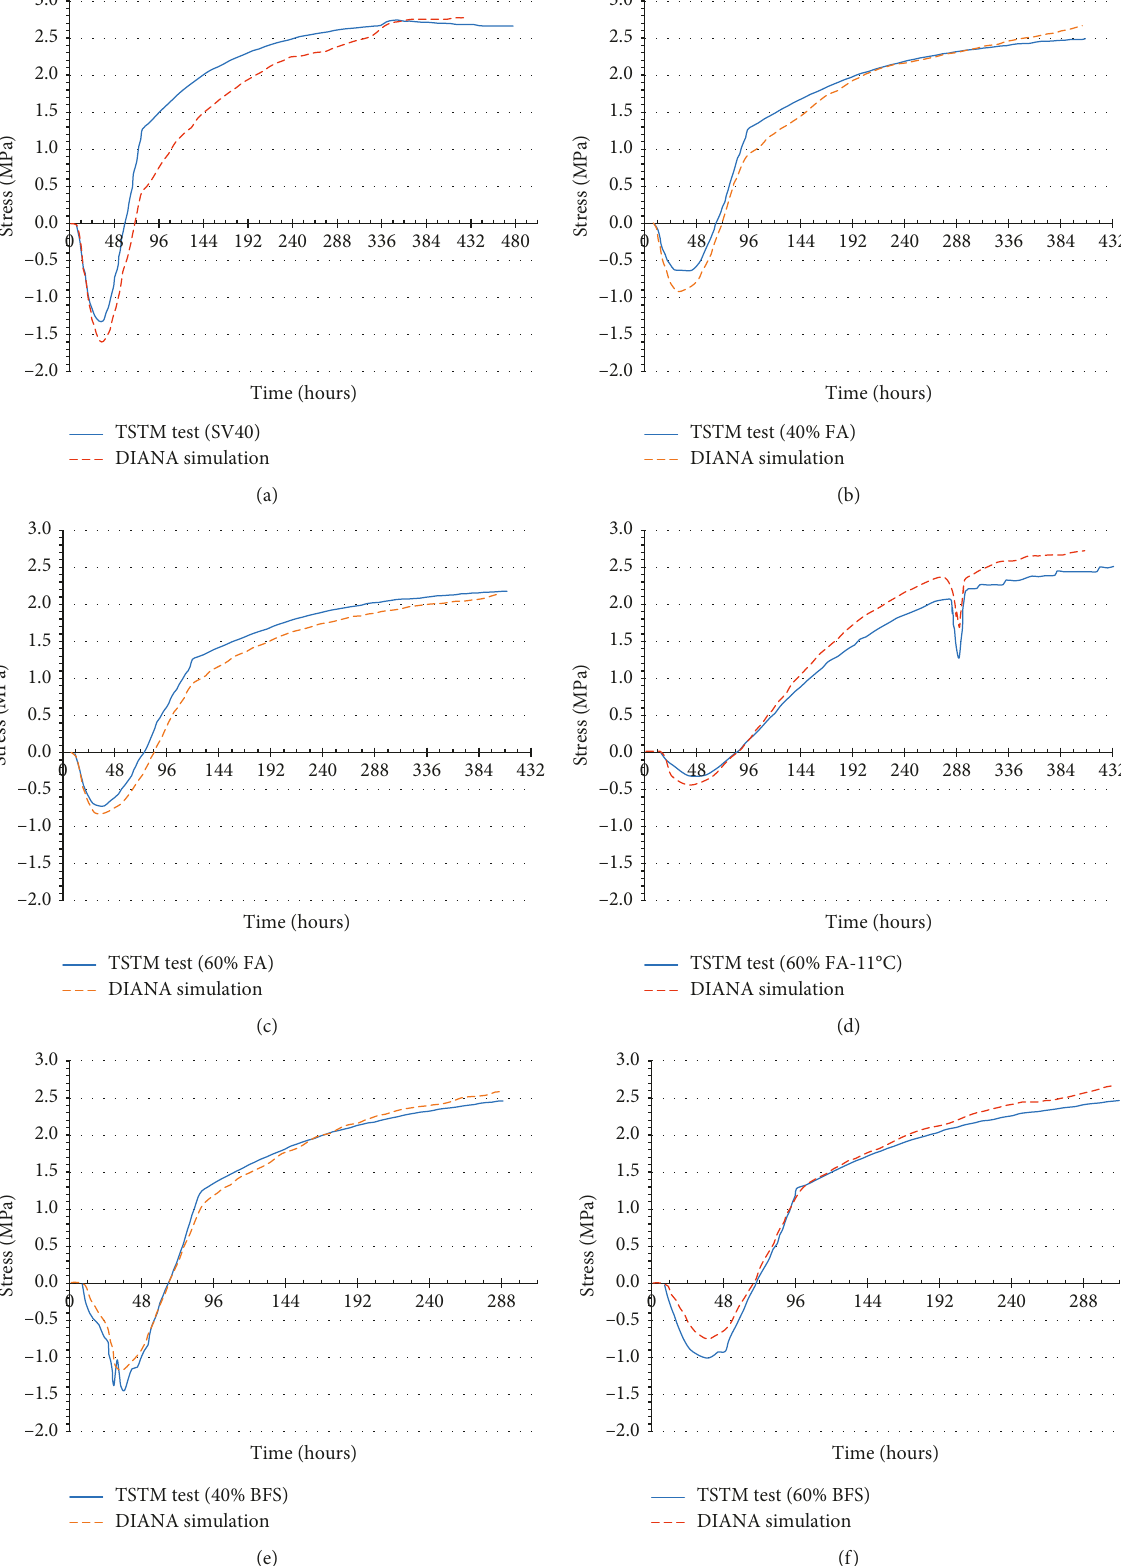
Figure 3: Calculated and measured stress development for the TSTM tests: (a) SV40; (b) 40% FA; (c) 60% FA; (d) 60% FA (11 ° C); (e) 40% BFS; (f) 60%